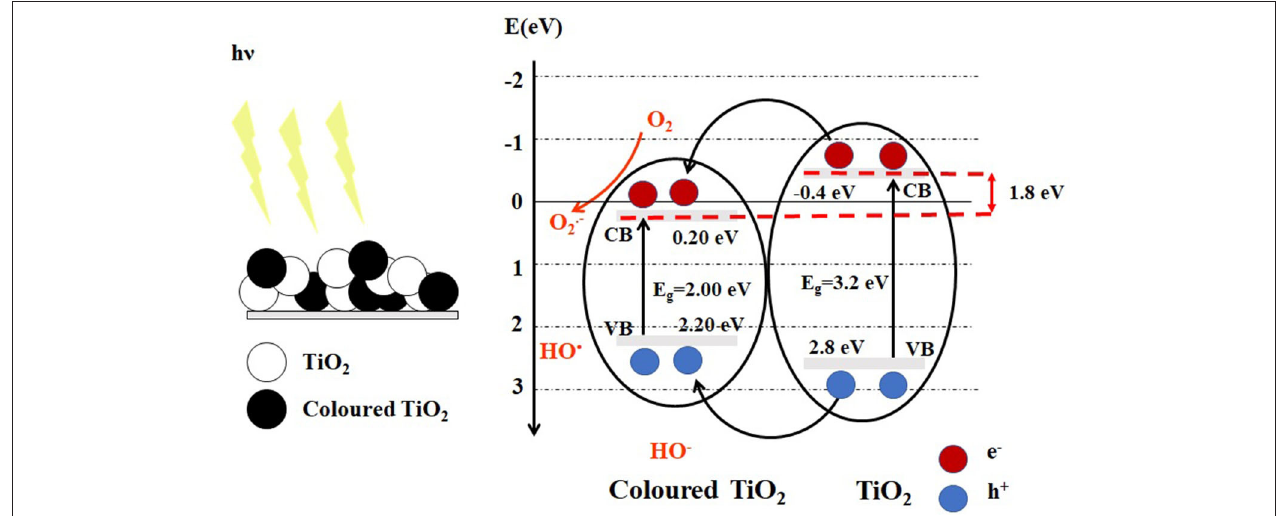
FIGURE 1 | The heterojunction between white TiO 2 and colored TiO 2